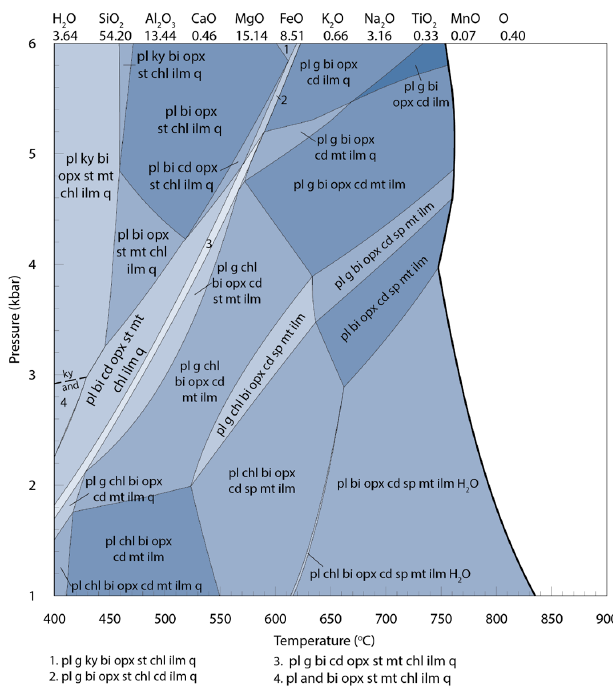
Figure 5. Calculated P – T pseudosection after the first melt reintegration (6% melt reintegrated). The bulk composition (in mol%) was calculated with the addition of 6% melt into the original granulite composition (Figure 4a) and is given above the pseudosection. The bold black line represents the solidus.